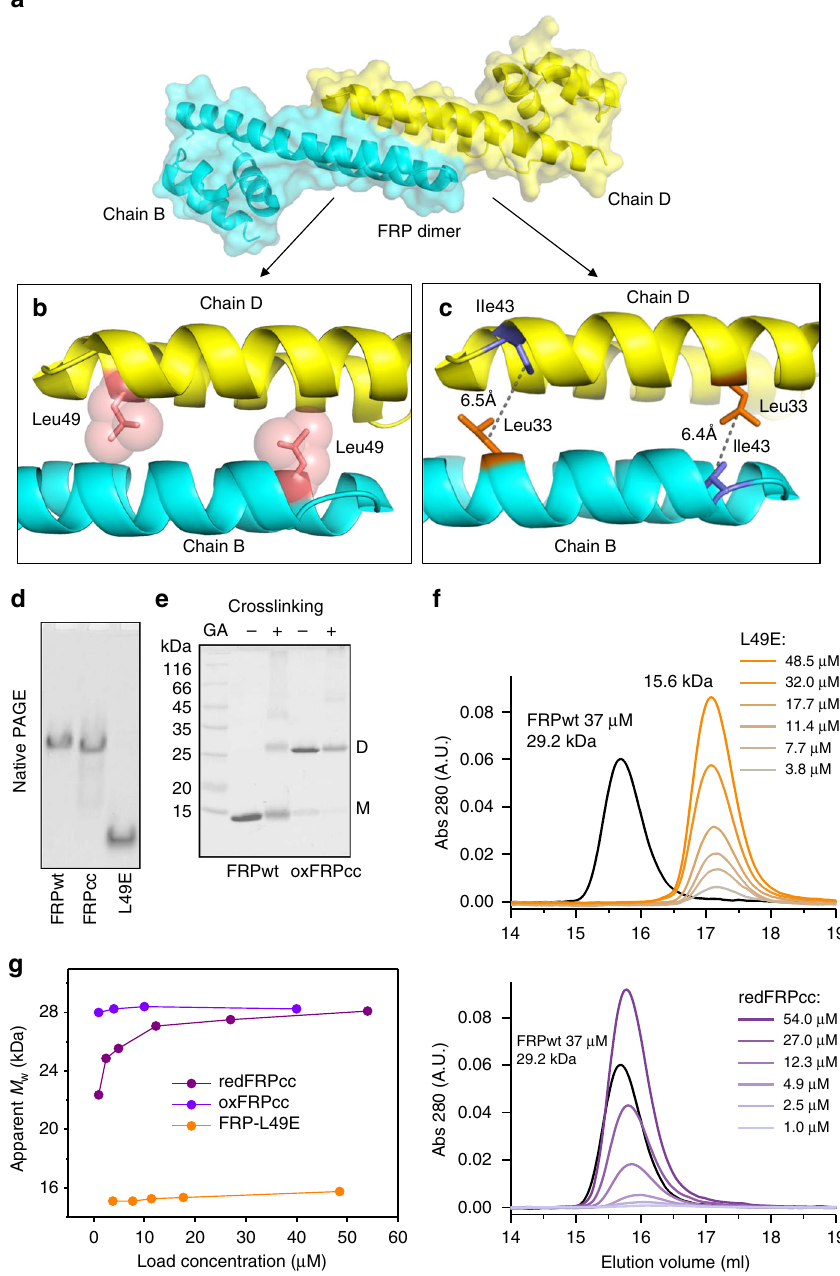
Fig. 1 FRP mutants with the prede fi ned oligomeric structure. a Overall view on the 4JDX structure of the Synechocystis FRP dimer with two subunits colored by yellow and cyan. b Close-up of the subunit interface showing positions of L49 residues (salmon sticks and semitransparent spheres) mutated to Glu to provoke dimer dissociation. c Close-up of the subunit interface showing positions of L33 (orange sticks) and I43 (slate sticks) residues as optimal candidates (C β atoms separated by ~6.5 Å) for the intersubunit disul fi de crosslinking. Analysis of the quarternary structure of the engineered FRP mutants using native PAGE ( d ) and chemical crosslinking followed by SDS-PAGE ( e ). FRPwt and oxFRPcc were crosslinked in the presence of GA ( + lanes); control samples ( − lanes) did not include GA. f Analytical SEC on a Superdex 200 Increase 10/300 column of the engineered FRP mutants at different FRP concentrations (indicated in µ M per monomer) under reducing conditions. g The dependence of the apparent M w for the FRP-L49E, oxFRPcc, and redFRPcc on loaded protein concentration as calculated from column